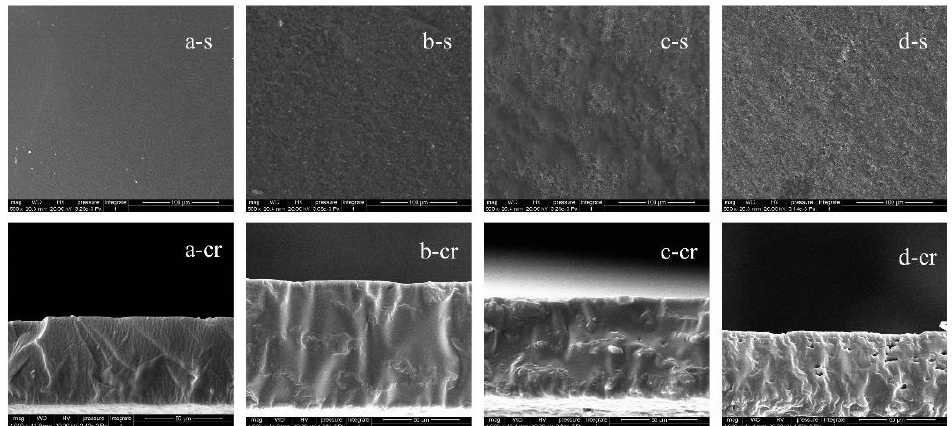
Figure 7. Surface (s; upper) (100 μ m) and cross-section (cr; lower) (50 μ m) microstructure images of CMC film and blended CMC – CFEO film: ( a ): control film (CMC); ( b ): CMC + 1% CFEO film; ( c ): CMC + 2% CFEO film; ( d ): CMC + 3% CFEO film.